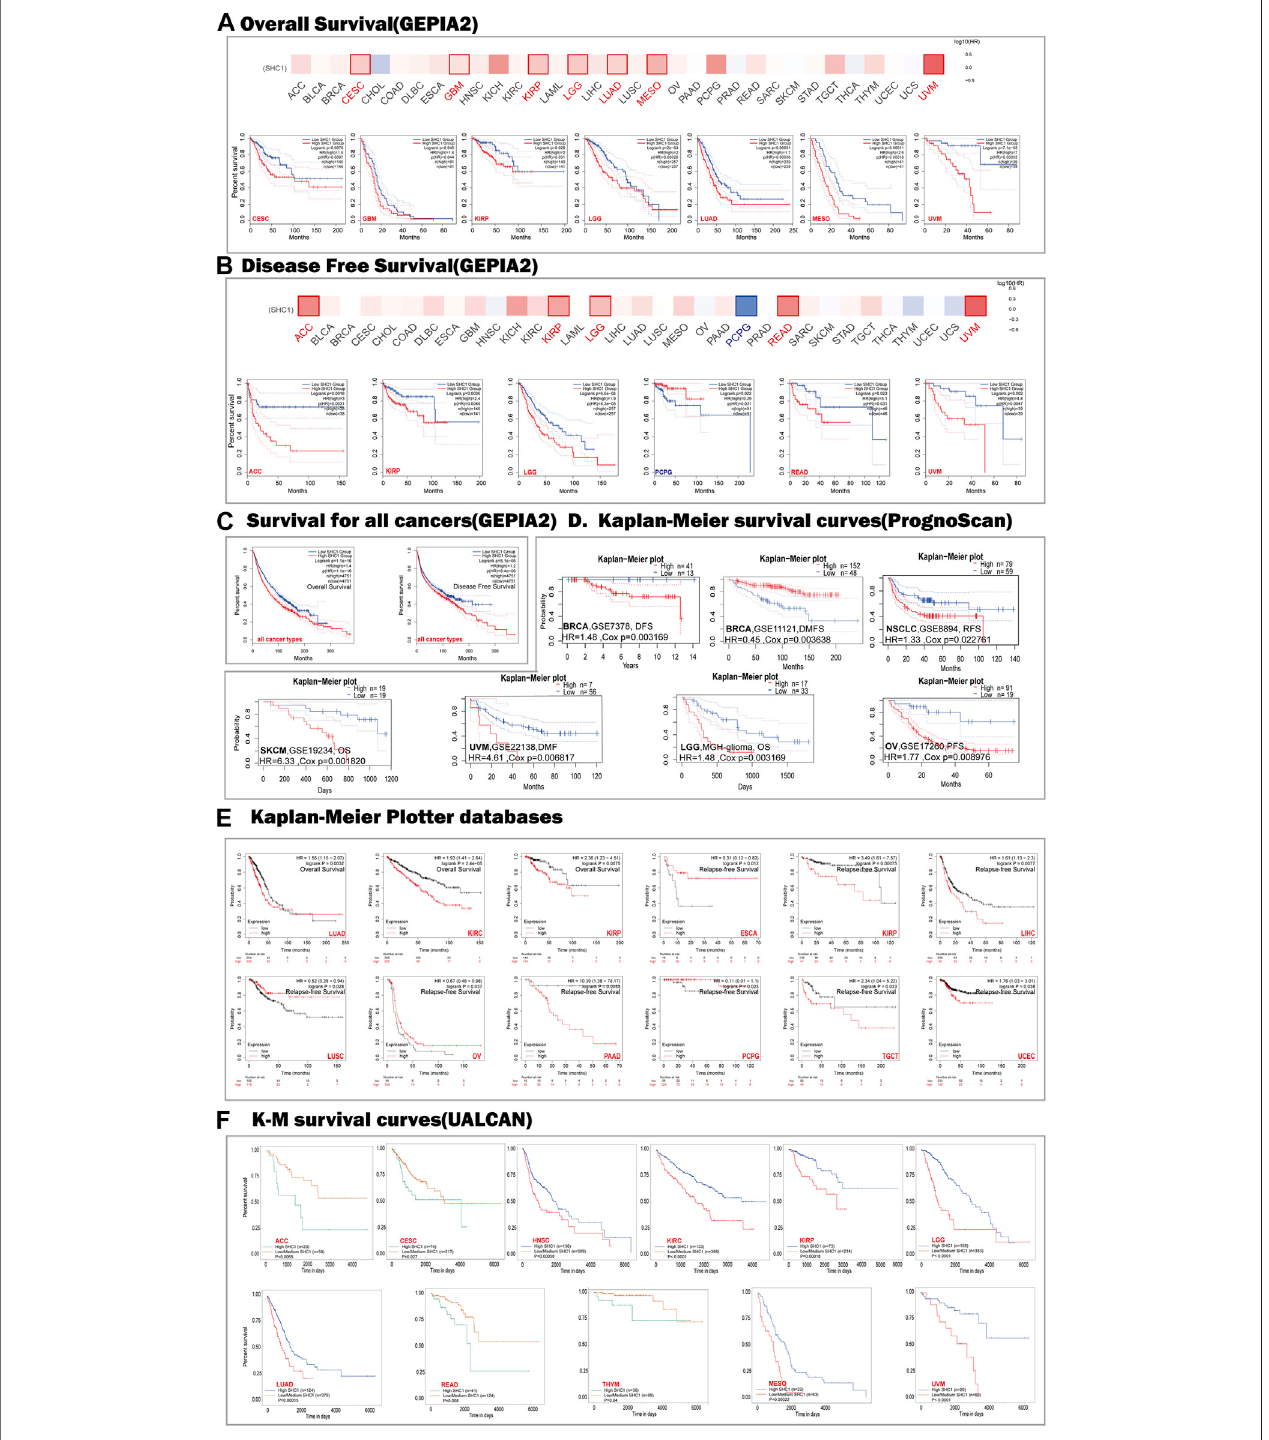
FIGURE 2 | Correlation between SHC1 expression and survival prognosis values in various cancers. The overall survival (OS) (A) disease-free survival (DFS) (B) of differenttumors,overallsurvival,anddisease-freesurvivalofallcancertypes (C) inTCGAdeterminedbyGEPIA2.ThesurvivalmapandKaplan-Meiercurveswithpositive results are shown. Relationship between SHC1 expression and patient prognosis of different cancer datasets obtained using PrognoScan (D) . Kaplan-Meier survival curves showing the survival of patients with high and low expression of SHC1 in Kaplan-Meier Plotter (E) . Kaplan-Meier survival curves showing the comparison betweenthe high and lowexpression ofSHC1 in UALCAN (F) .DFS, disease-free survival; DMFS, distantmetastasis-free survival;RFS, relapse-free survival;OS, overall survival; PFS, progression-free survival.